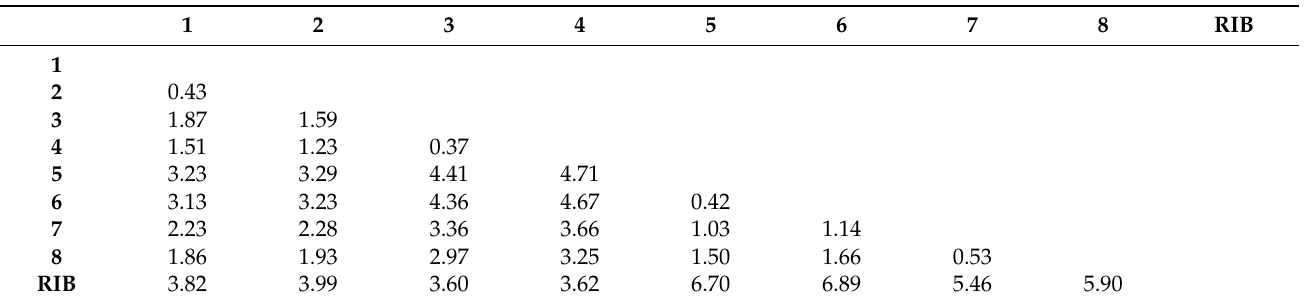
Table 5. Color distance ( ∆ E) calculated for all possible pairs of samples. Samples 1–8 belong to the FDOE; RIB is the reference